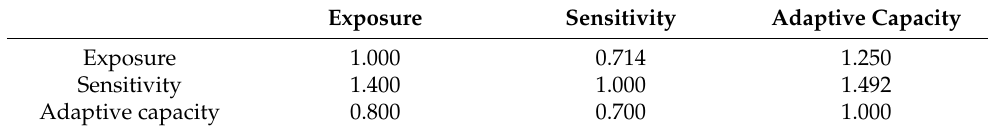
Table 4. The index scale result in AHP.